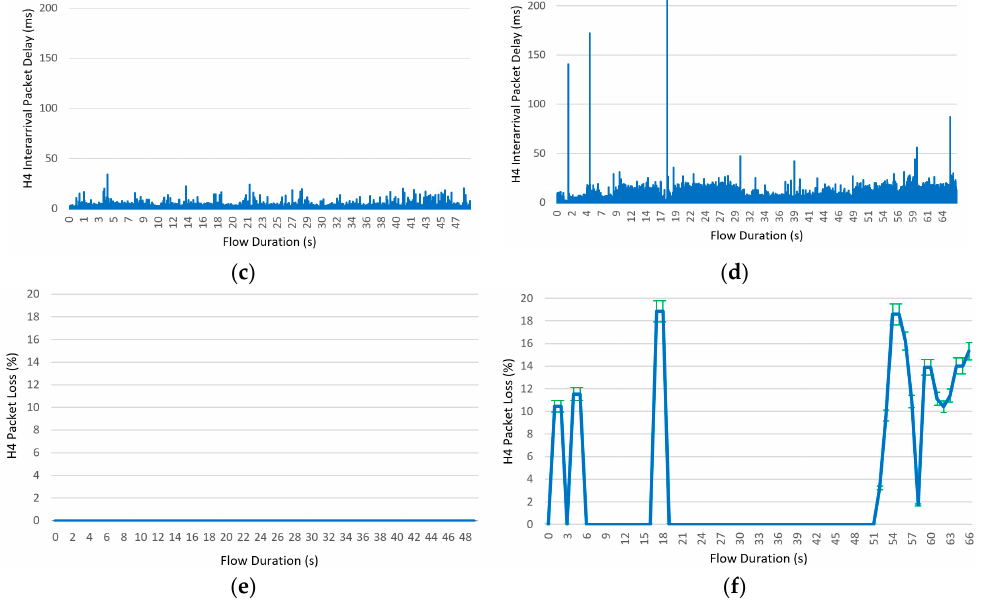
Figure 9. Average results of flow rate, flow interarrival packet delay, and flow loss percentage for the two compared controllers, during a 50 s service session between client h1 and data server h4. The proactive controller results are shown on the left side, and the reactive controller results are shown on the right. ( a ) Flow rate (Kb/s) for the proactive controller, ( b ) flow rate (Kb/s) for the reactive controller, ( c ) flow interarrival delay (ms) for the proactive controller, ( d ) flow interarrival delay (ms) for the reactive controller, ( e ) flow loss percentage for the proactive controller, ( f ) flow loss percentage for the reactive controller. In ( a , b , f ), the variation bars around non-null average results are visualized in green.